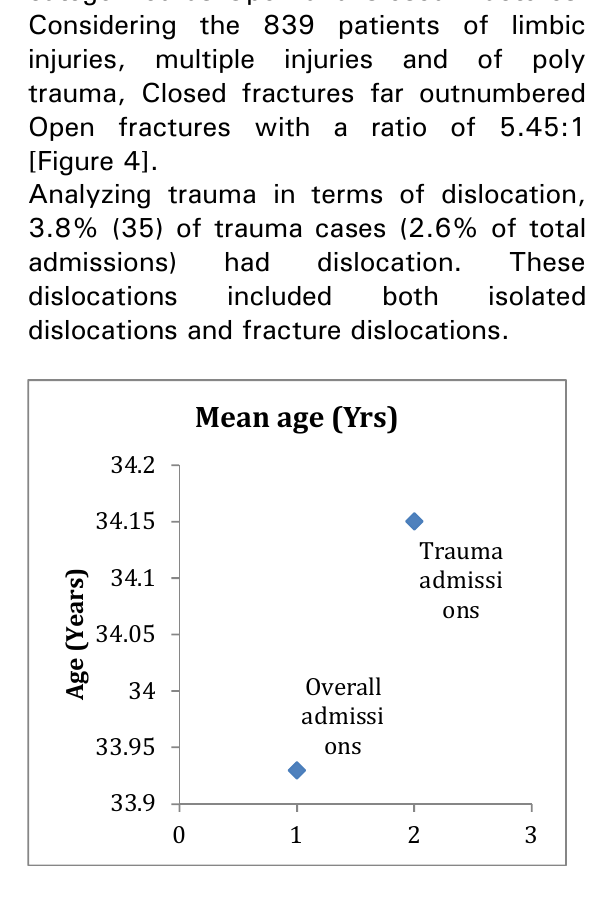
Figure 5. Mean age of admitted patients